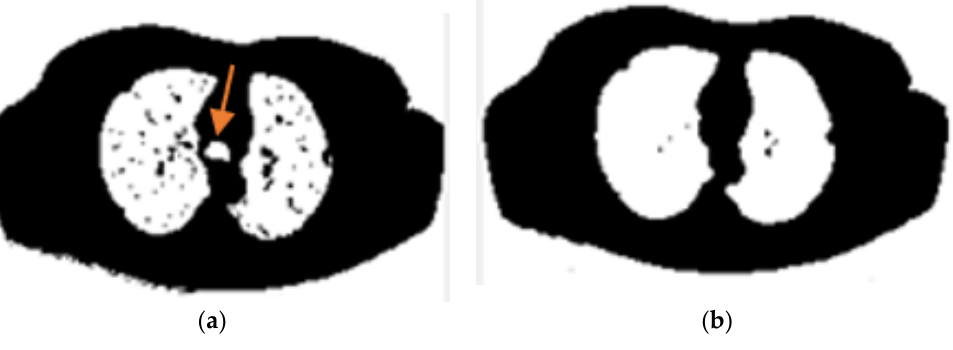
Figure 9. Image after ( a ) . binarization; ( b ) . dilation.